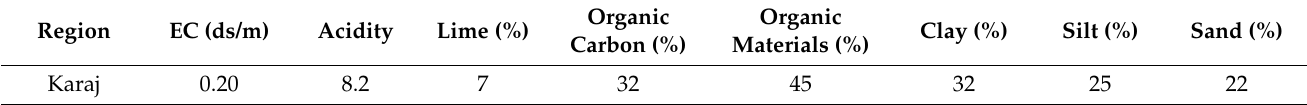
Table 9. Soil characteristics of the cultivated area in the